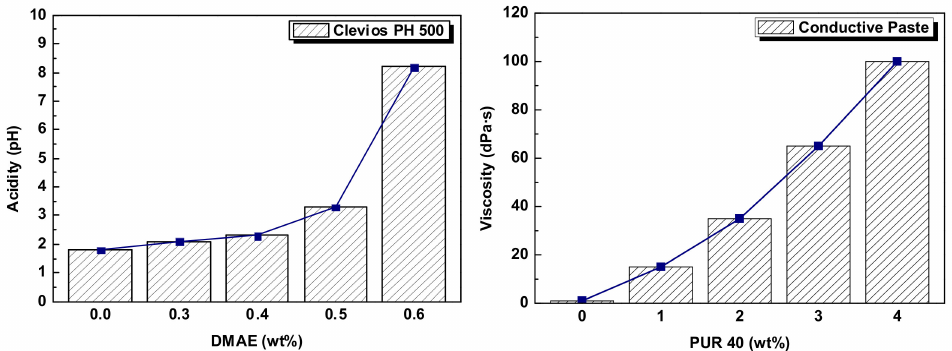
Figure 1. Change in acidity of Clevios PH 500 and the viscosity of conductive